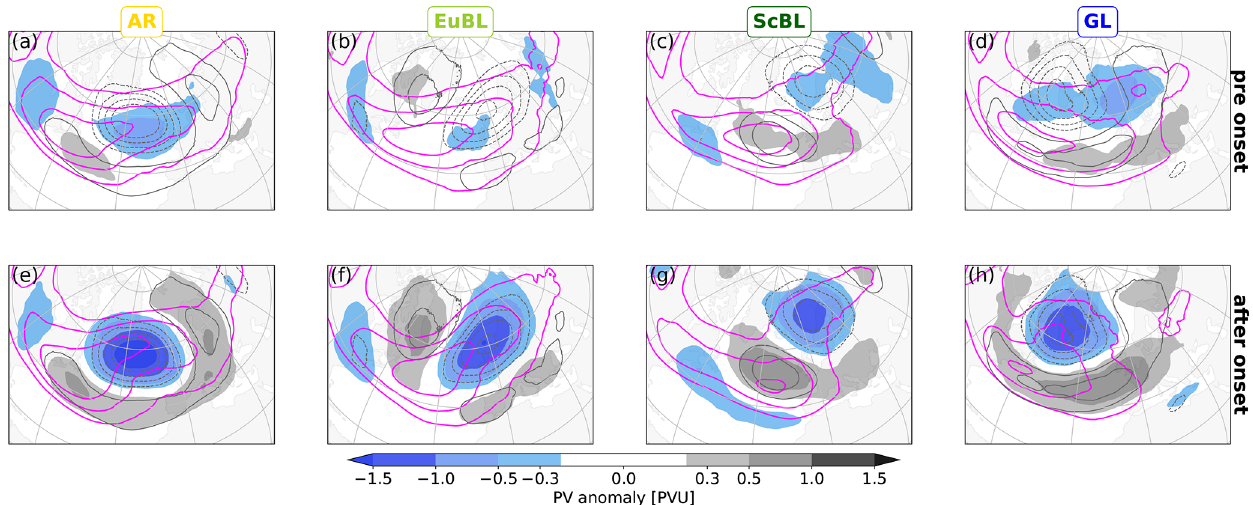
Figure 3. Composite maps of low-frequency PV anomalies (shading). Upper row (a–d) : before onset (averaged from 3 to 1d before on- set). Bottom row (e–h) : after onset (averaged from 1–3d after onset). The respective regime is given at the top of each column. Magenta contours depict the envelope of synoptic-scale Rossby waves (for [15, 18, 21]ms − 1 ). Grey contours depict the PV regime pattern (for ± [0.2, 0.4, 0.6, 0.8]PVU, negative values dashed).